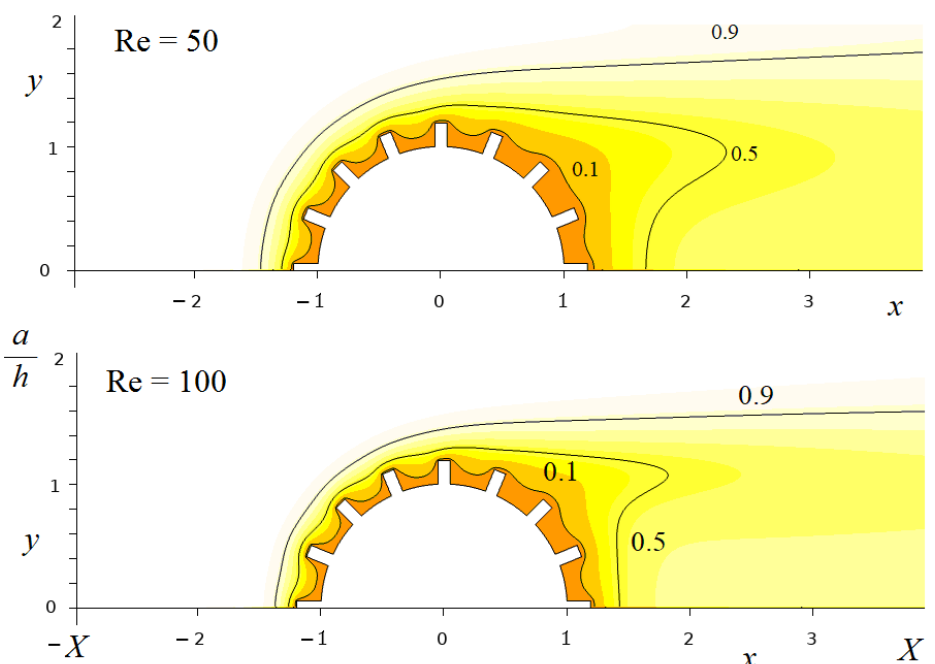
Figure 1. Distribution of the dimensionless concentration of the point particles in the transverse flow past a row of parallel profiled fibers with protrusions for different Reynolds numbers; the concentration values are marked on the curves; Sc = 1; a / h = 0.5; flow direction from left to right.